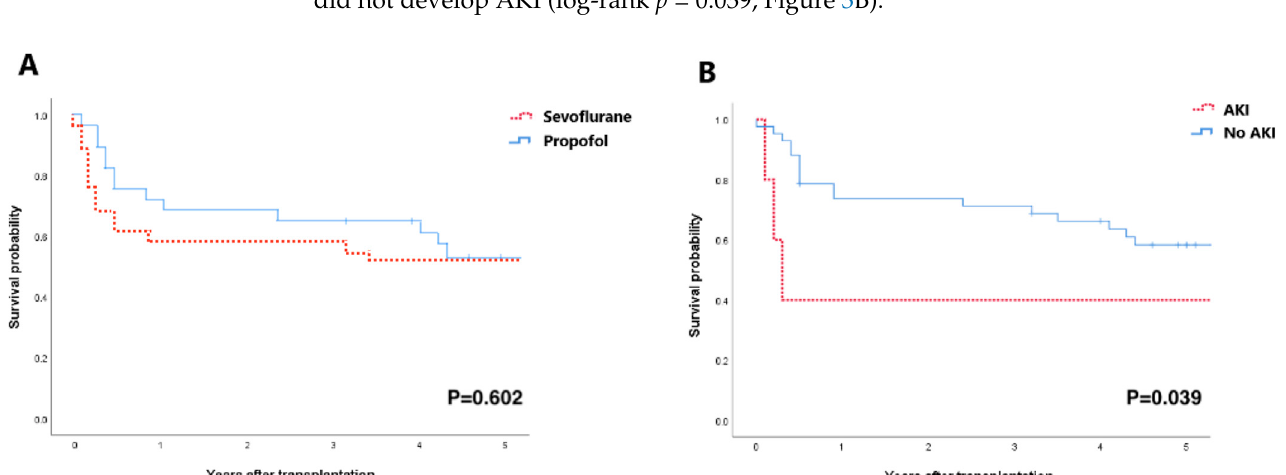
Figure 2. Serum levels of inflammatory cytokines and antioxidant enzymes. P GroupxTime = p -value of the group and time interaction obtained by the linear mixed model.